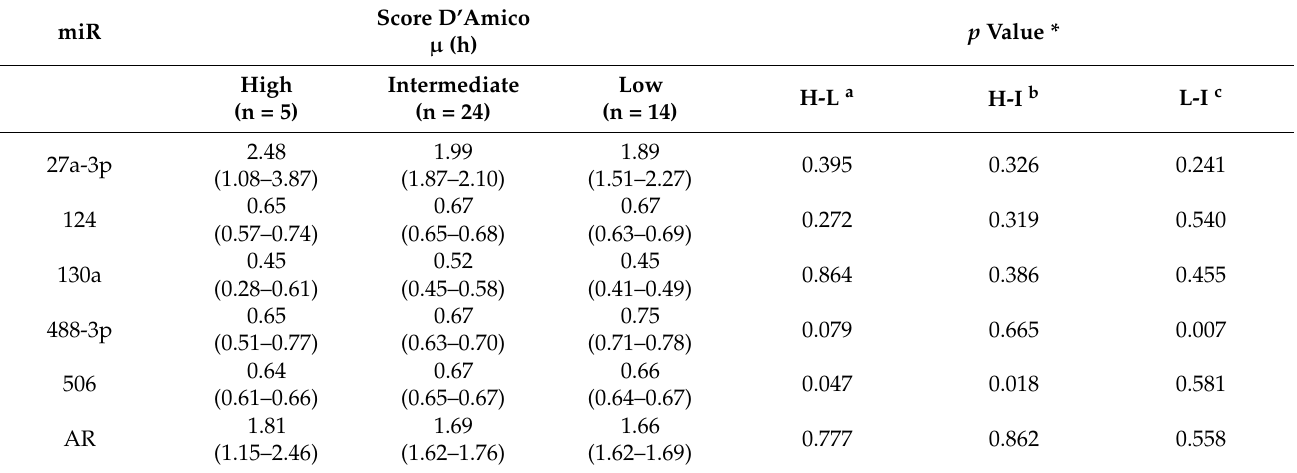
Table 1. Comparison by the D’Amico score and the relative prostate levels of AR and miRs